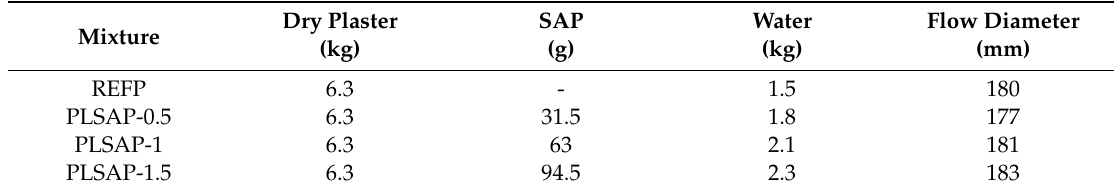
Table 1. Composition of the studied plasters.